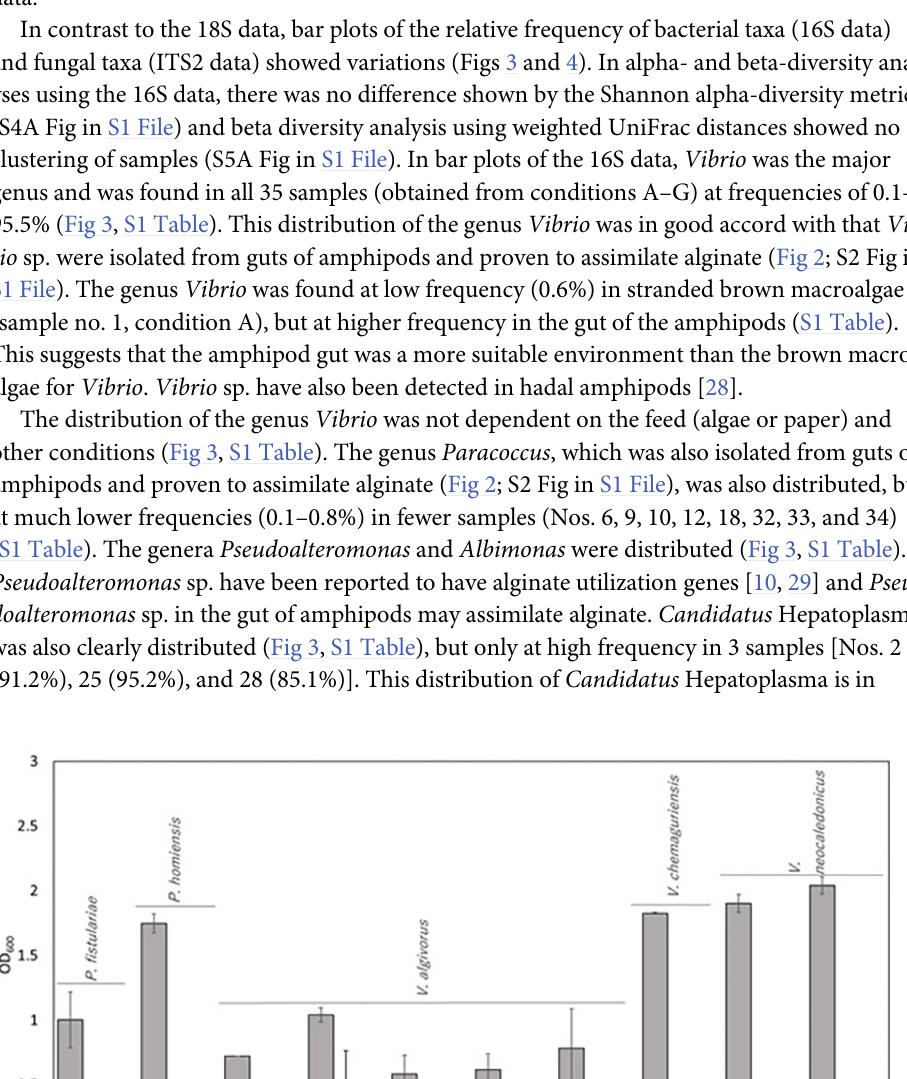
Fig 1. Feeding of talitrid amphipods on brown macroalgae and paper. (A) Images of stranded brown macroalgae with 30 individual amphipods (+) or without amphipods (-) after the indicated periods. (B) Images of papers with 18 individual amphipods (+) or without amphipods (-) after the indicated periods.